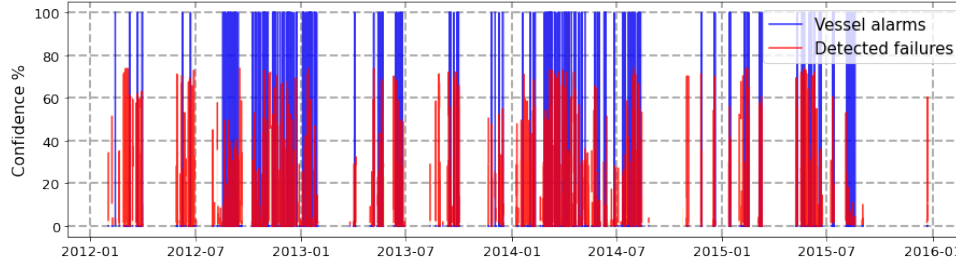
Figure 6. Normalized comparison of the vessel alarms (in blue) with the autoencoder’s joint diagnos- tics for all failure modes. Data comes from a BAM ship. y -axis represents the confidence given by the autoencoder. x -axis represents normalized data coming from the vessel.